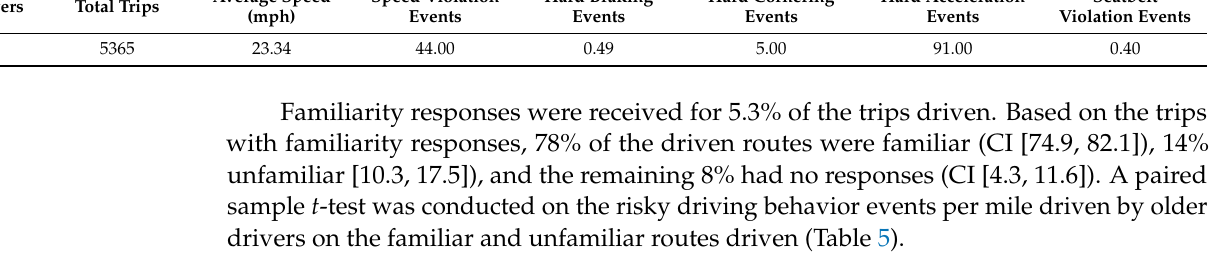
Table 5. Paired sample t -test was conducted on the risky driving behavior events per mile driven by older driver on familiar and unfamiliar routes. Risky Driving For Familiar Routes Behavior Events/mile